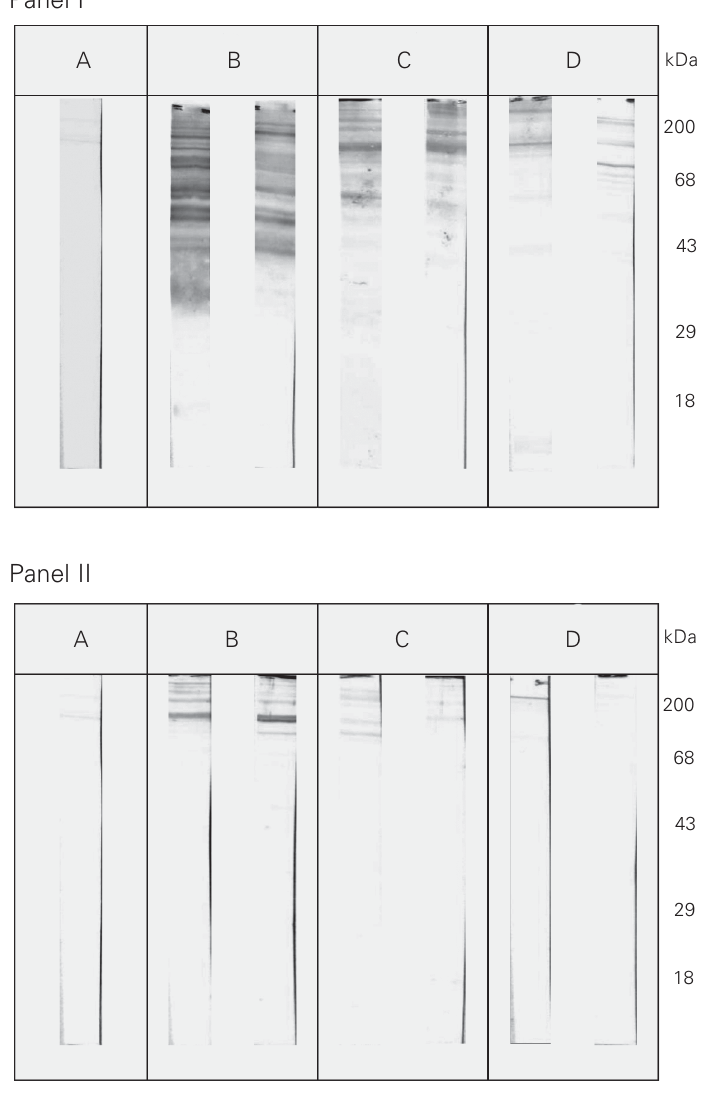
Figure 1. Western blot of sera from patients with chagasic (Panel I) and non-chagasic (Panel II) heart disease using T. cruzi total cell extract. Two sera from each group were chosen to illustrate the results. A , Normal human serum. B , Sera with high reactivity to ELISA. C , Sera with medium reactivity to ELISA. D , Sera with low reactivity to ELISA. The molecular weights are indicated in